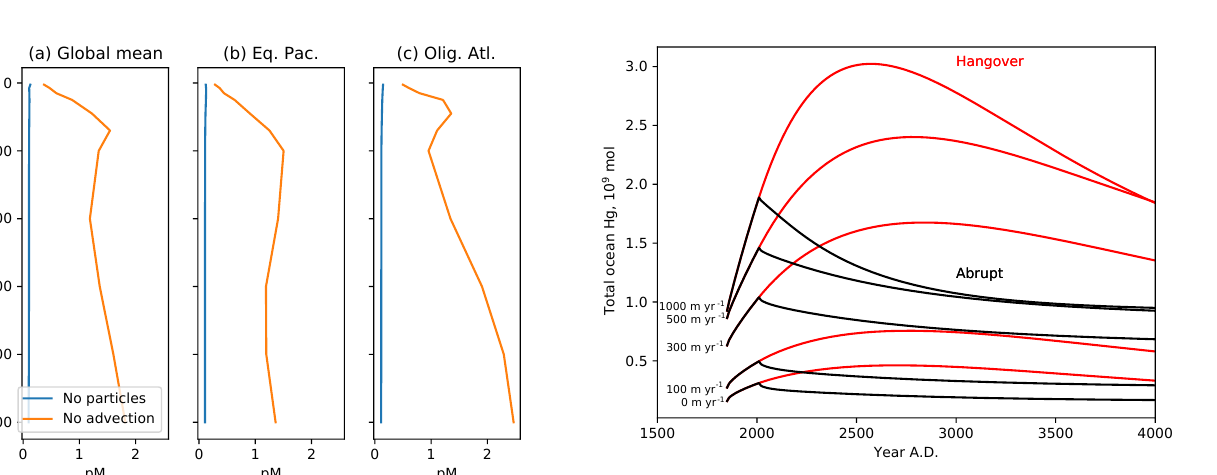
Figure 8. Profiles of mean Hg concentration in (preanthropogenic) steady state, as a function of depth in the ocean, in equilibrium, for the end-member cases of no particles (blue lines), and no advection (orange lines). (a) Panels are global mean, others are from locations in Fig. 4. If there were no particles, the Hg concentration would be homogenized throughout the ocean by the circulation. If there were no circulation, the concentration in the steady state would increase with depth in the ocean, because there are fewer sinking particles at depth, so the Hg abundance per particle has to increase, as does therefore the dissolved Hg concentration in the ocean.